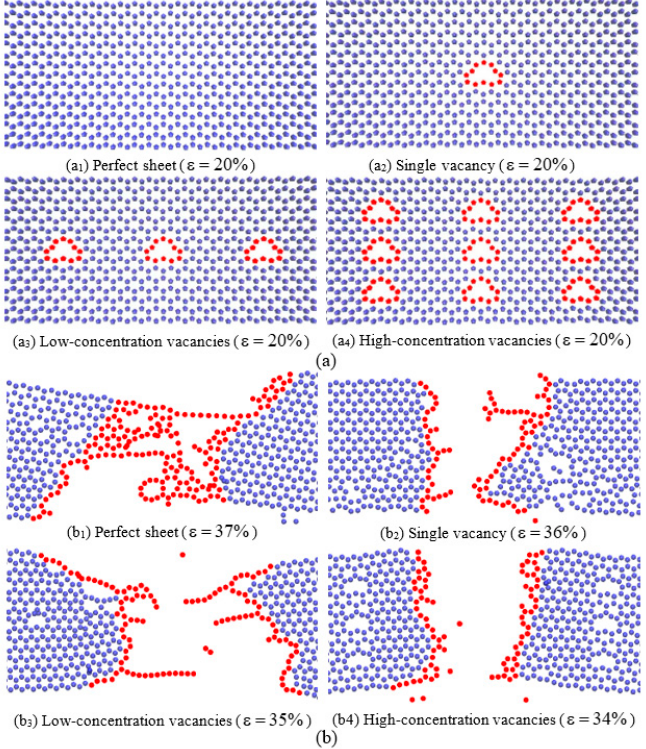
Figure 3. Local atomic configurations of SLGSs with different vacancy concentrations during ( a ) elastic ( ε = 20%), ( a 1 ) Perfect sheet, ( a 2 ) Single vacancy, ( a 3 ) Low-concentration vacancies and ( a 4 ) High-concentration vacancies, and ( b ) fracture processes, ( b 1 ) Perfect sheet, ( b 2 ) Single vacancy, ( b 3 ) Low-concentration vacancies and ( b 4 ) High-concentration vacancies.